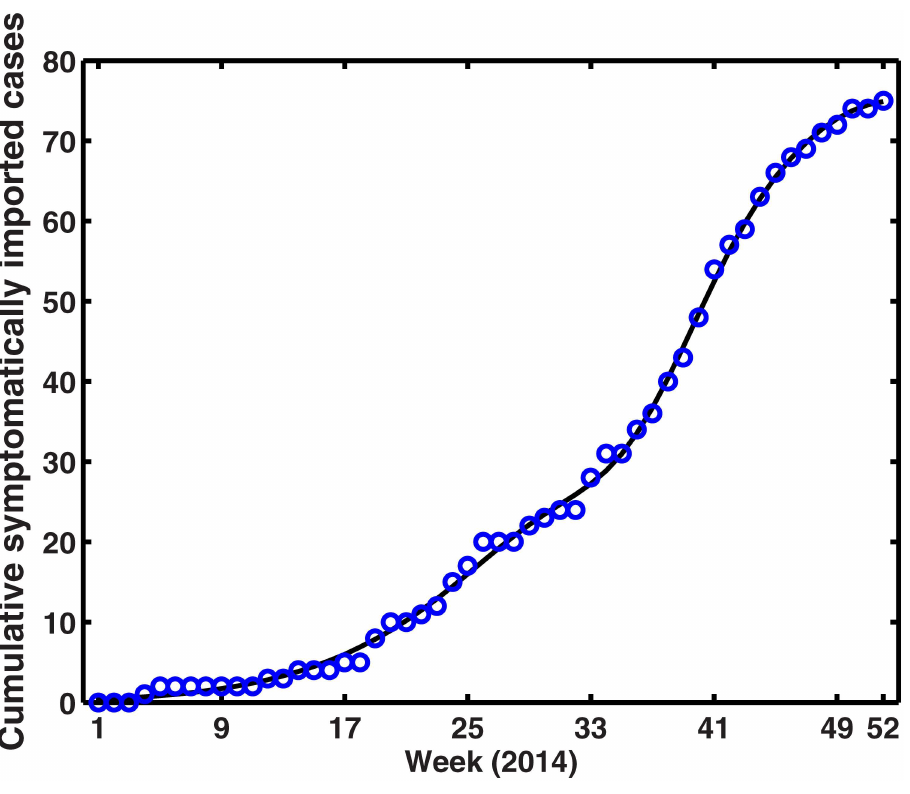
Fig 6. The weekly simulation result of cumulative symptomatically imported dengue cases with Eq (10) in 2014. The blue circles indicate the reporting weeklycumulativesymptomatic imported dengue cases, while black line shows model output. The expression is Z ð t Þ ¼ b b 1 = − 9.252, b 2 = 35.91, b 3 = 5.854, b 4 = 75.04, b 5 = 52.94 and b 6 = 22.61, respectively.